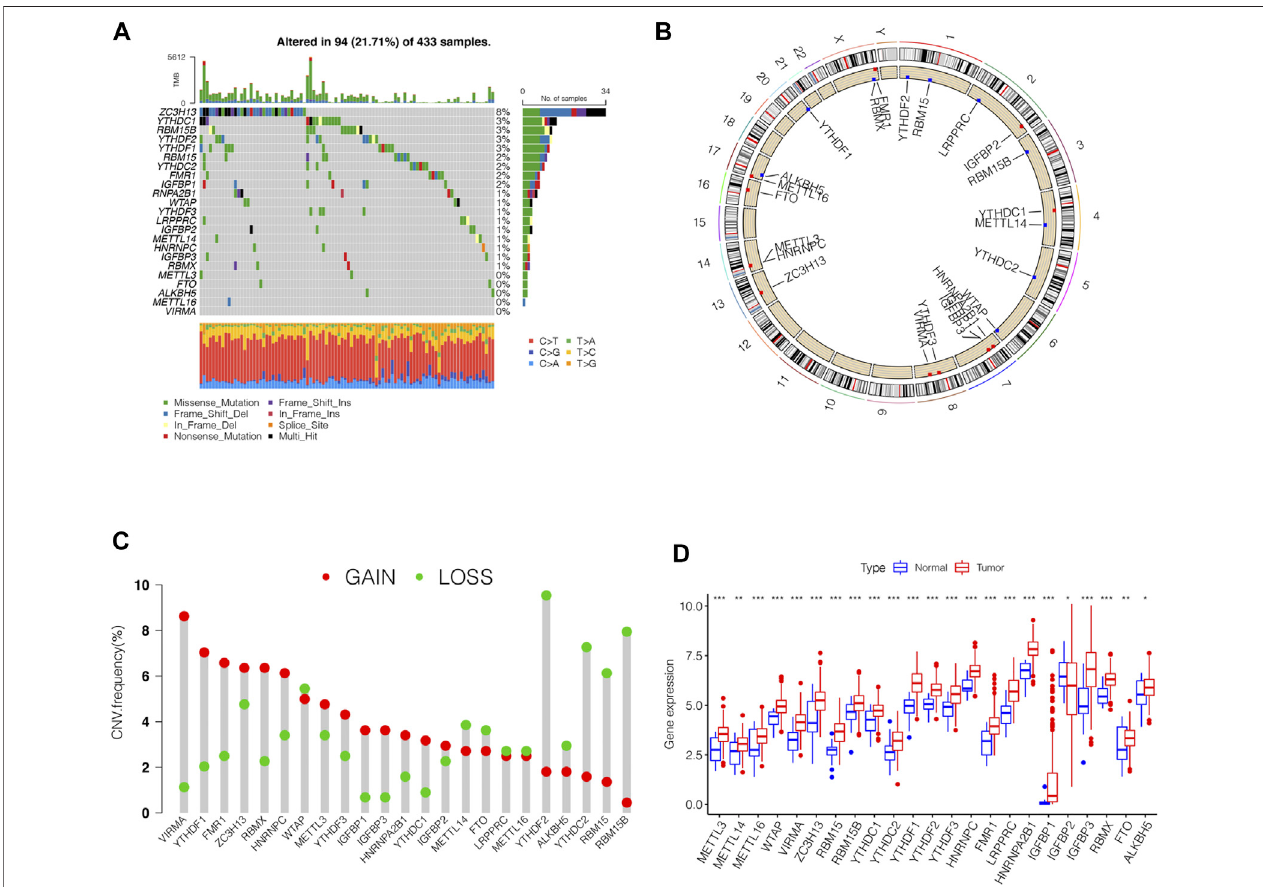
FIGURE 1 | Genetic variation pro fi le of m6A regulators in STAD. (A) Mutation frequency of the m6A regulators of stomach adenocarcinoma patients in the TCGA- STAD cohort. (B) Location of CNV changes of 23 m6A regulators on the chromosome. (C) A histogram plotting the CNV mutation frequency of each gene obtained by statisticalanalysisofthecopynumberofm6A.Theabscissawasthem6A-relatedgene,andtheordinatewasthemutationfrequency. (D) Theboxplotofm6Adifferential expression analysis in the tumor and normal samples. The asterisks represented the statistical p value ( ppp p < 0.0001, pp p < 0.01, p p < 0.05).